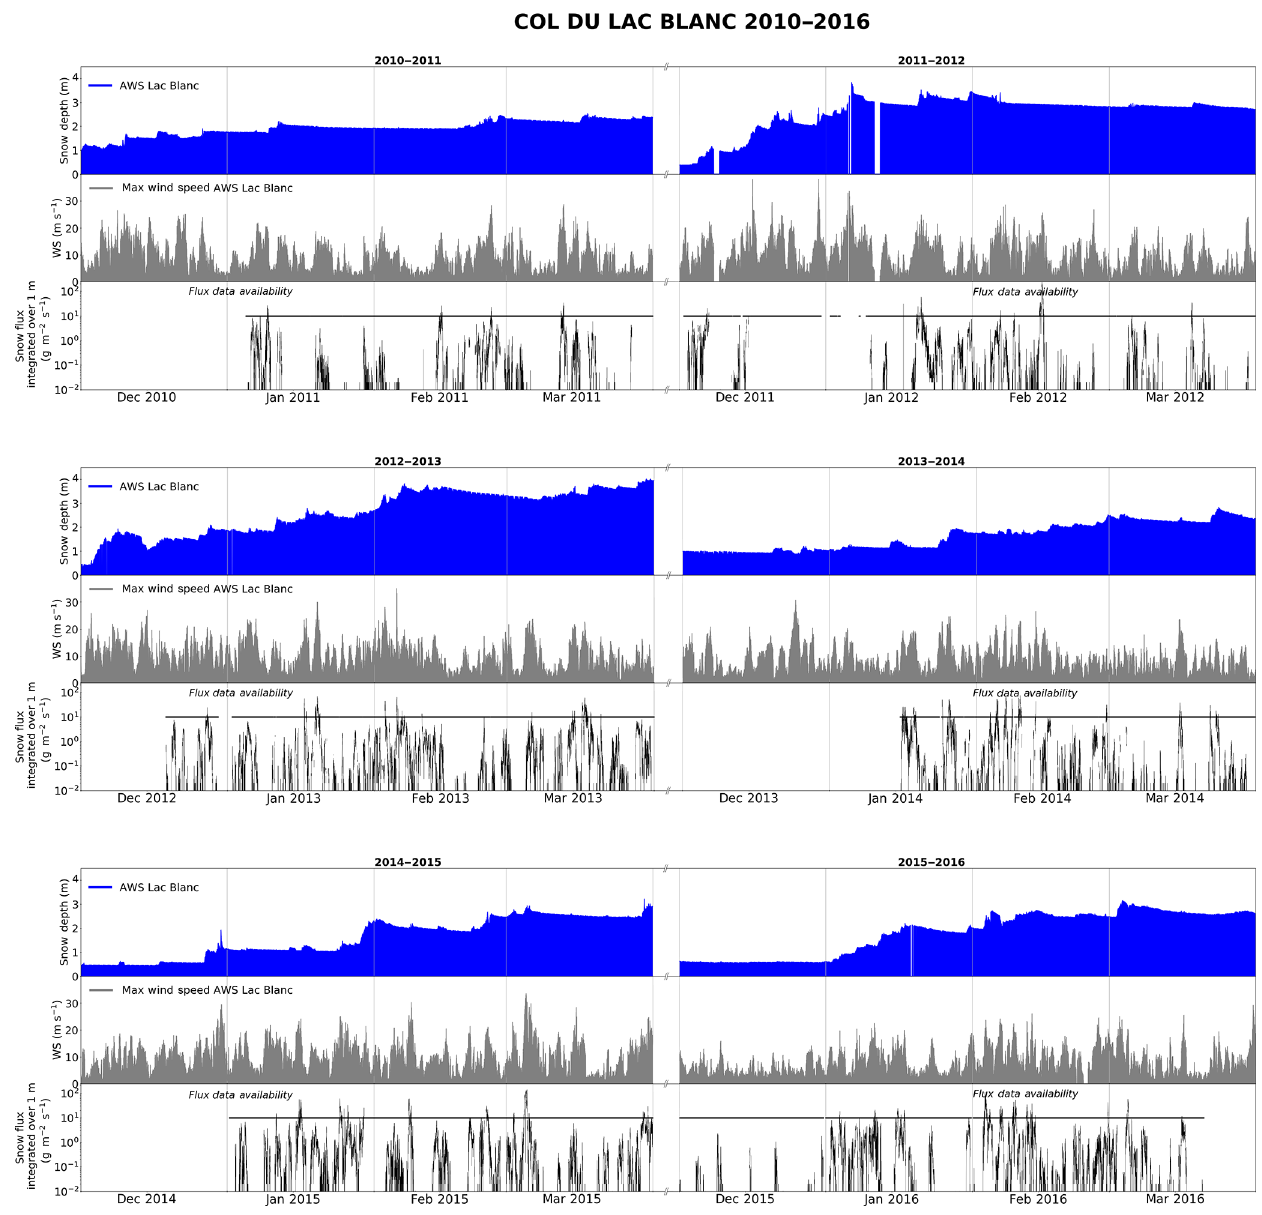
Figure 6. Overview of snow depth (AWS Lac Blanc), maximum wind speed (AWS Lac Blanc) and blowing snow fluxes measured by SPC- S7 vertically integrated between 0.2 and 1.2m (AWS Col) from 2010 to 2016. More detailed yearly graphs are provided as a supplement for each snow season from 2000–2001 to